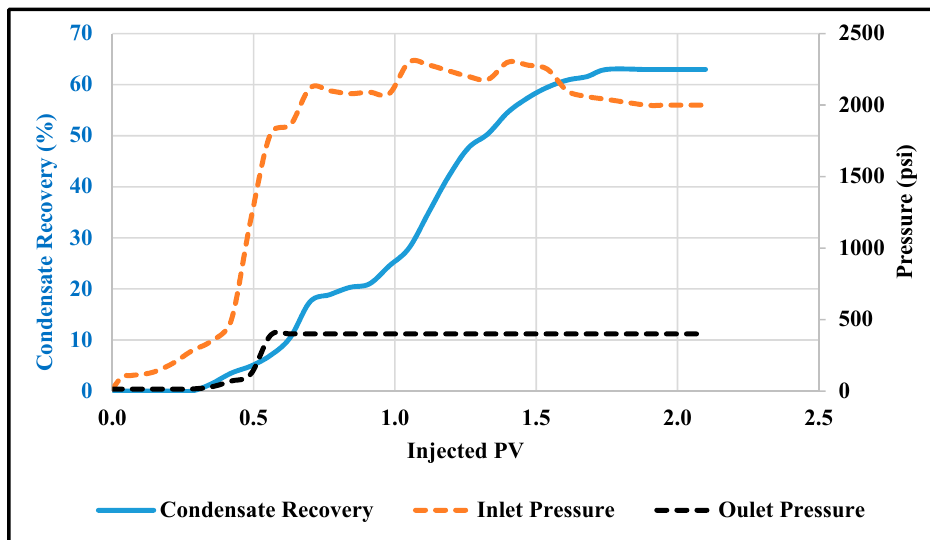
Figure 3. Profiles of condensate recovery, inlet, and outlet pressures for continuous injection of thermochemical fluids. Energies 2018 , 11 , x FOR PEER REVIEW